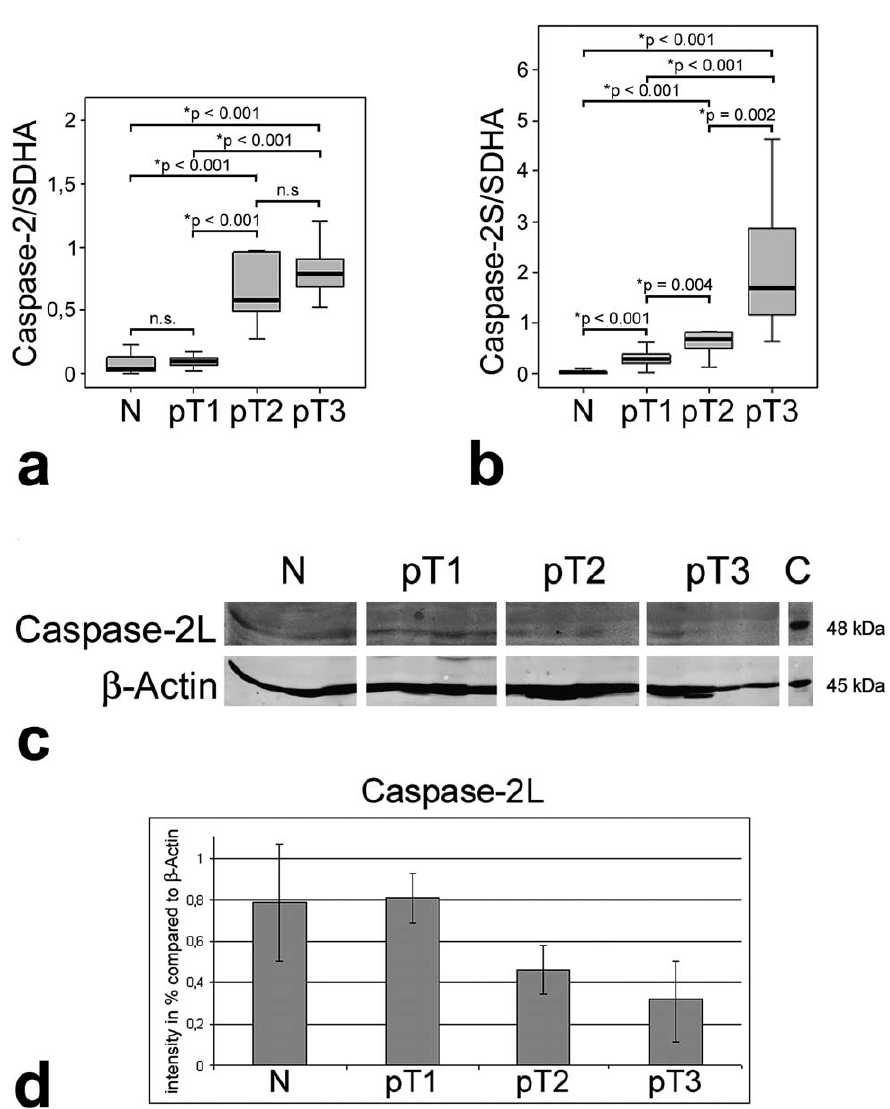
Fig. 2. SDHA-normalized total caspase-2 and caspase-2S mRNA expression as well as caspase-2L protein expression in non-neoplastic renal tissue and in RCCs of different tumour stages. (a) Significantly increased relative total caspase-2 mRNA expression (i.e. SDHA-normalized total caspase-2 expression) in pT2 and pT3 RCCs when compared to non-neoplastic renal tissue (N) and pT1 RCCs. No difference between relative total caspase-2 mRNA expression in RCCs infiltrating beyond the kidney borders (pT3) and pT2 RCCs. (Significant results are indicated ∗ p .) (b) Significantly increased relative caspase-2S mRNA expression (i.e. SDHA-normalized caspase-2S expression) in pT1 RCCs when compared to non-neoplastic renal tissue. Further increase in relative caspase-2S mRNA expression in pT2 RCCs compared to pT1 RCCs and in pT3 RCCs compared to pT2 RCCs. (Significant results are indicated ∗ p .) (c) Four arbitrarily selected non-neoplastic tumour tissues and four arbitrarily selected tumour tissues of each stage were analysed by Western Blot. No difference in caspase-2L protein expression between non-neoplastic renal tissue and pT1 RCCs. Decreased caspase-2S expression in pT2 RCCs compared to non-neoplastic renal tissue and pT1 RCCs with further decrease in pT3 RCCs. (d) For relative quantification the intensity of the Western Blot band of caspase-2L obtained by densitometry was normalized to the intensity of the band of β -actin for each sample (given is the relative intensity in % of the β -actin band). Data represent the means and the standard deviations of the four non-neoplastic renal tissues respectively the four RCC samples of each tumour stage investigated by Western